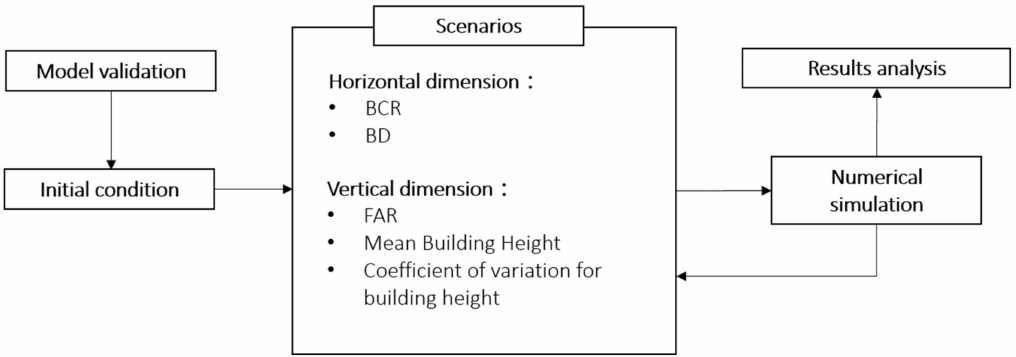
Figure 2. Flowchart for scenario simulation.